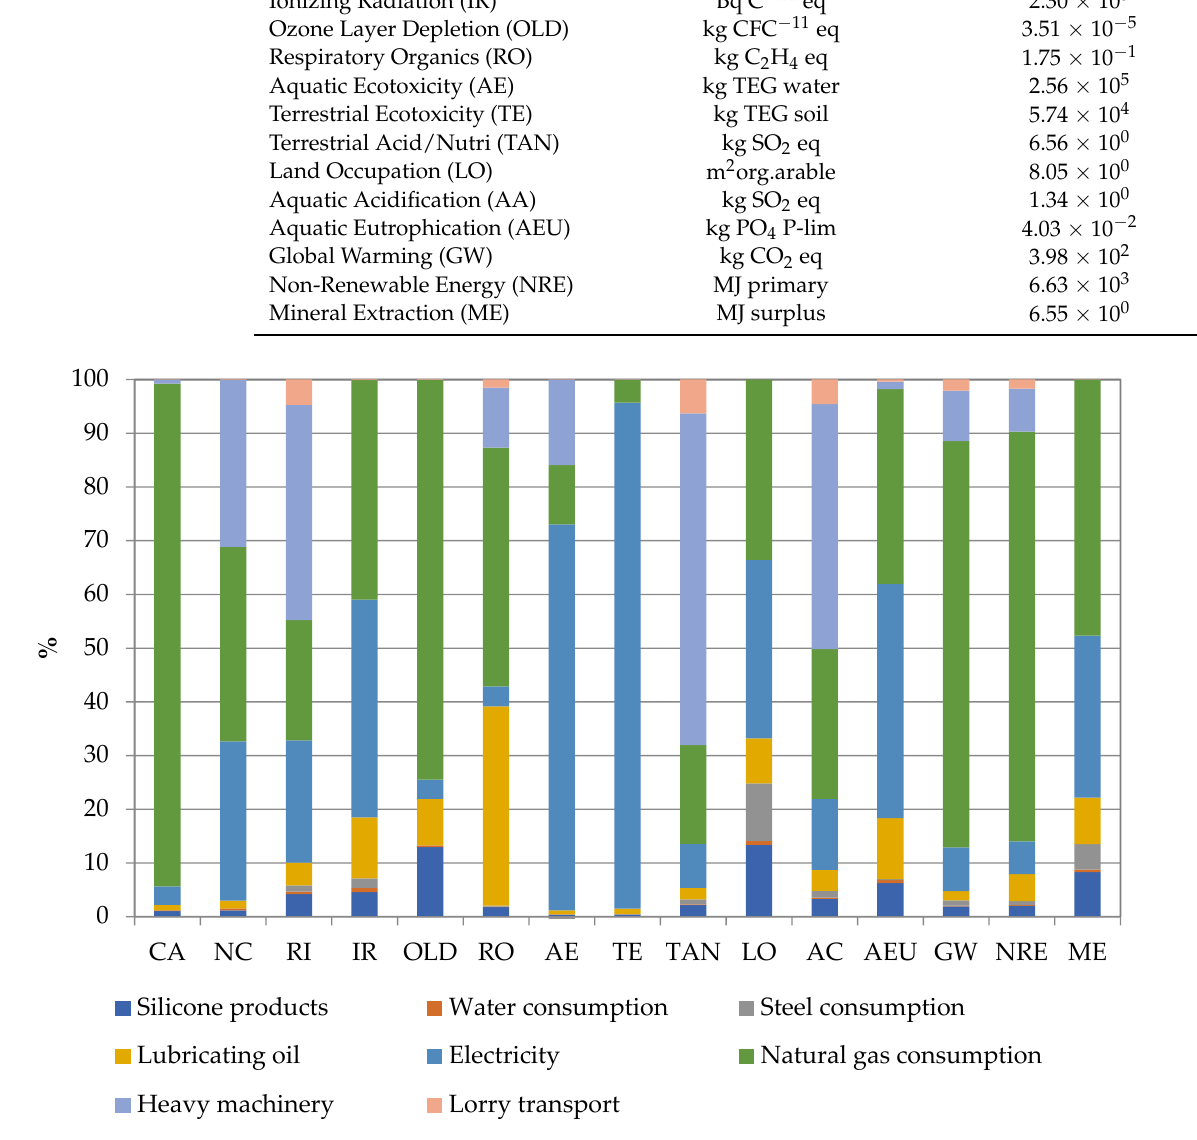
Figure 2. Midpoint impacts of basalt fiber